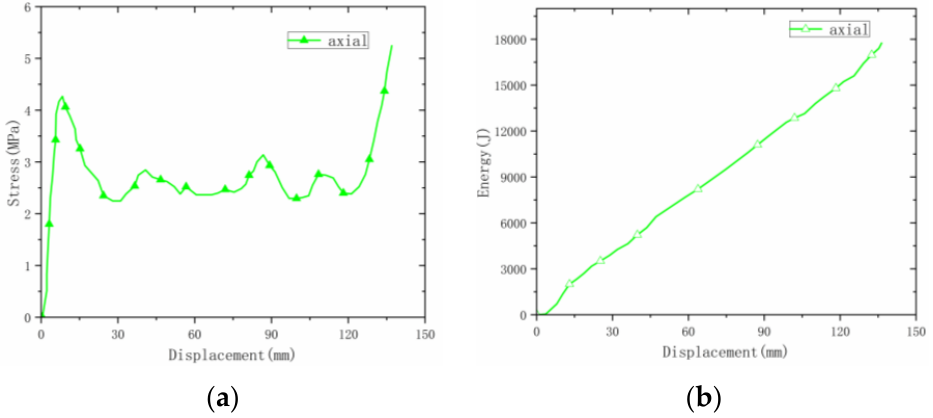
Figure 9 . Axial stress – displacement and energy-absorption curves of welded origami hon- Figure 9. Axial stress–displacement and energy-absorption curves of welded origami honeycomb 3. eycomb 3. ( a ) Stress – displacement curve. ( b ) Energy – displacement curve.